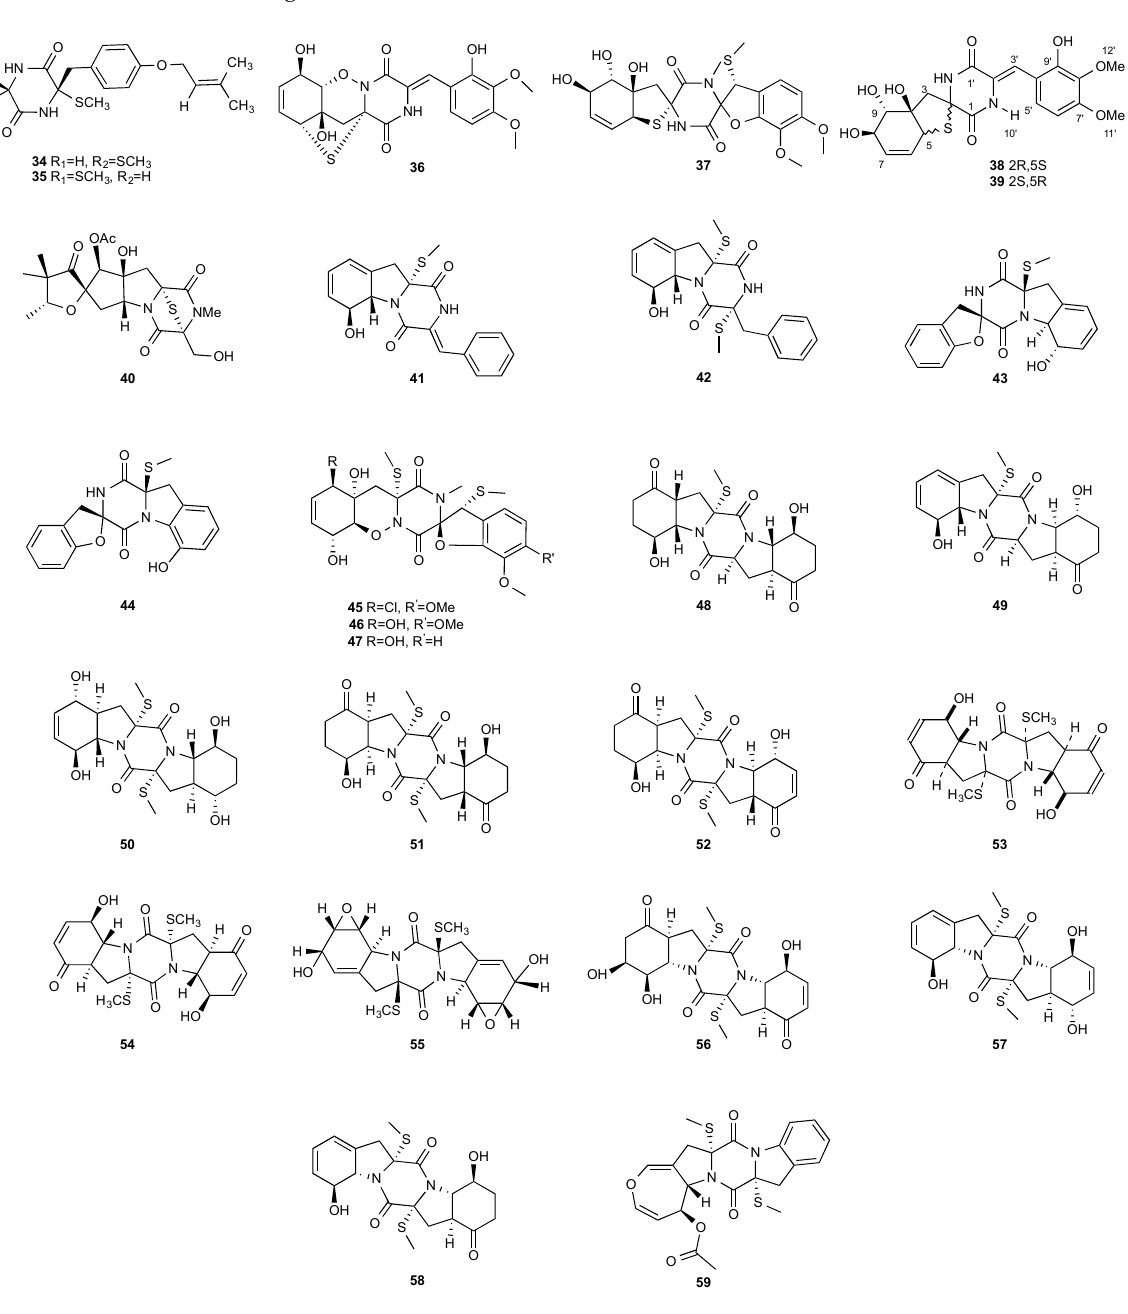
Figure 2. Structures of compounds 34 – 59 . Four new dioxopiperazine alkaloids, penispirozines A − D ( 36–39 ), were produced by Penicillium janthinellum HDN13-309, which was isolated from the root of the mangrove